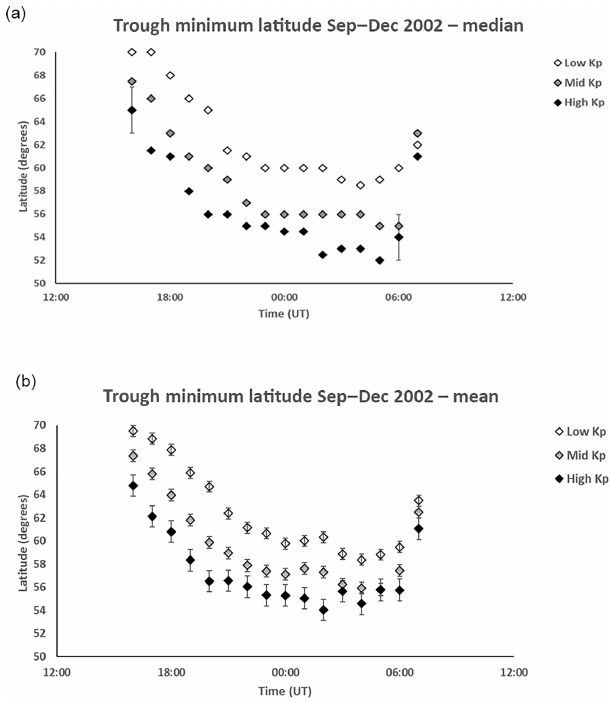
Figure 3. (a) Median latitudes for the trough minimum from 16:00 to 07:00UT for low Kp (0 to 2 + ) , medium (“Mid”) Kp (3 − to 4) and high Kp ( ≥ 4 + ). The representative interquartile range shown on two points is approximately 4.0 ◦ latitude. The trough minimum occurs at the highest latitudes in early evening and moves progres- sively equatorward with increasing time before retreating rapidly poleward near 07:00UT. (b) Mean latitudes for the trough mini- mum from 16:00 to 07:00UT for low Kp (0 to 2 + ) , medium Kp (3 − to 4) and high Kp ( ≥ 4 + ) . The bars show the standard error in the mean for each point. The trends in the plot are the same as for the median values in Fig. 3a.